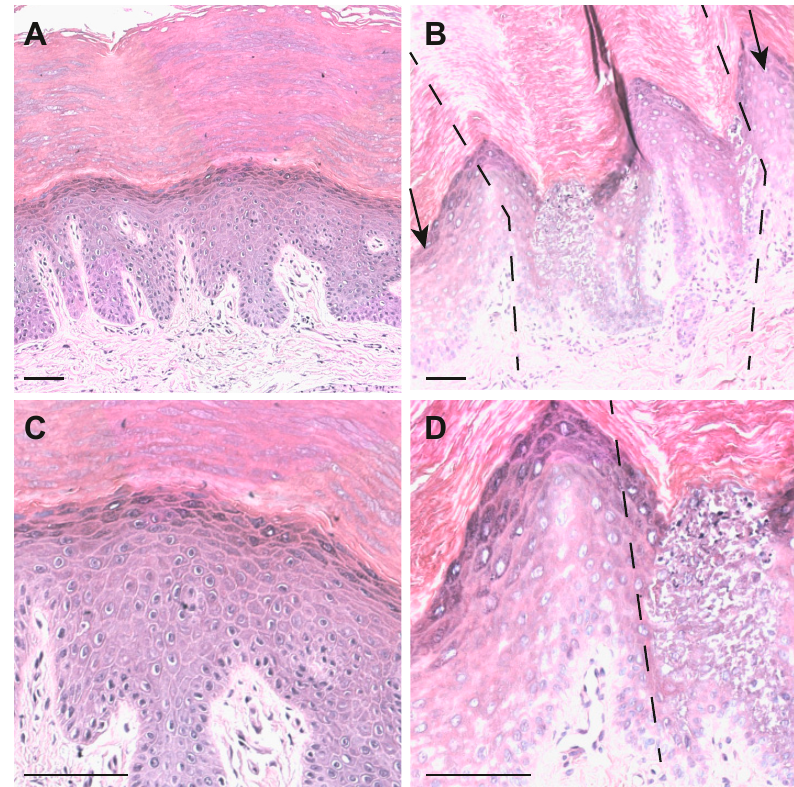
Figure 2. HE staining of palmar skin. ( A ) Control palmar skin. ( B ) Patient palmar skin. Dashed lines and arrows indicate the joint between nevoid lesion and non or low lesional skin (10× objective). ( C ) Control palmar skin. ( D ) Patient palmar skin (20× objective), low lesional skin is on the left side of the dotted line. Bars = 50 μ m.